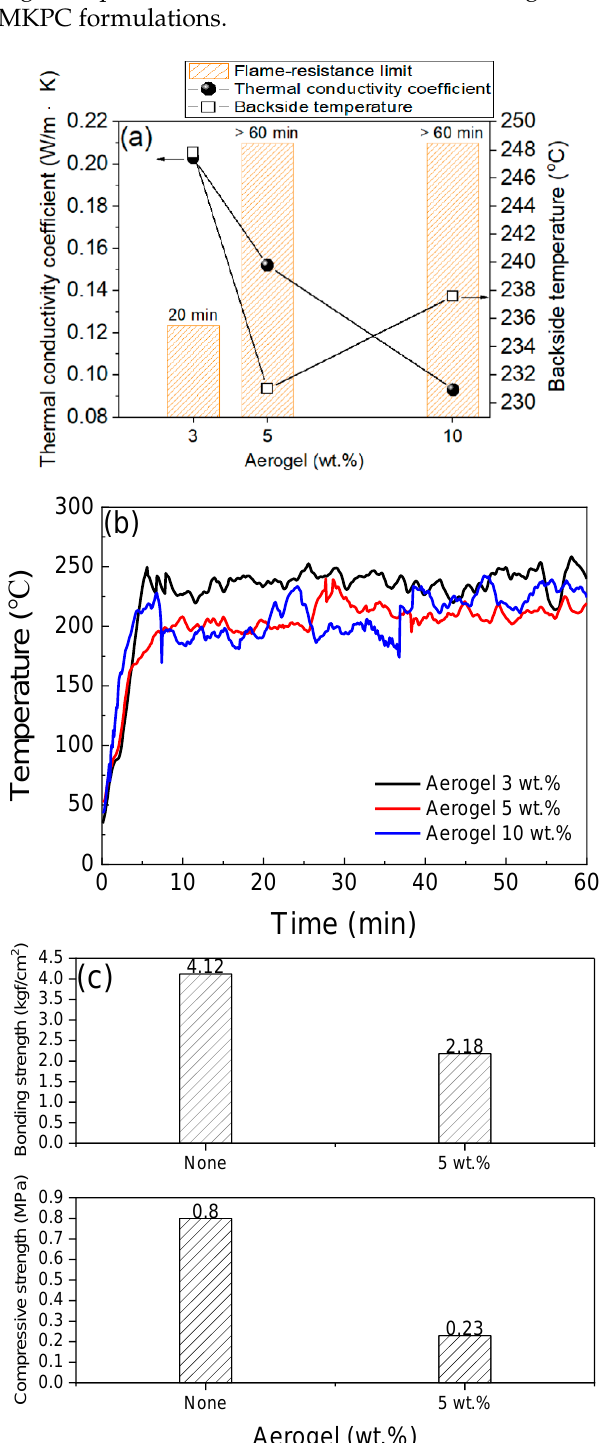
Figure 5. ( a ) Thermal conductivity, backside temperature for steel substrate, flame-resistance limit to different contents of aerogel and, ( b ) mechanical strength ( c ) bonding and compressive strength with 0 and 5 wt.% aerogel of the MKPCs. (magnesia/KH 2 PO 4 molar ratio = 4; wollastonite:vermiculite = 20:10 wt.%).